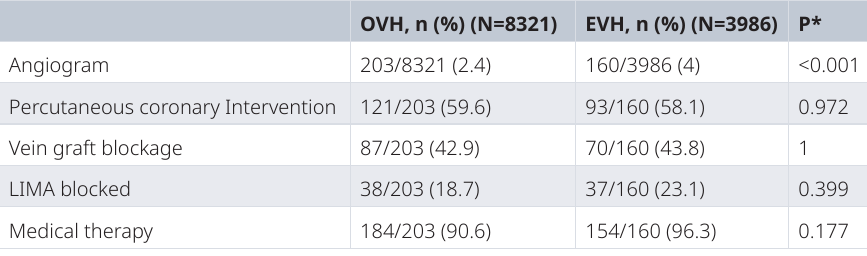
Table 4. Number of angiograms, graft occlusions and percutaneous coronary interventions. Data available for Wythenshawe and Blackpool symptomatic patients who had follow